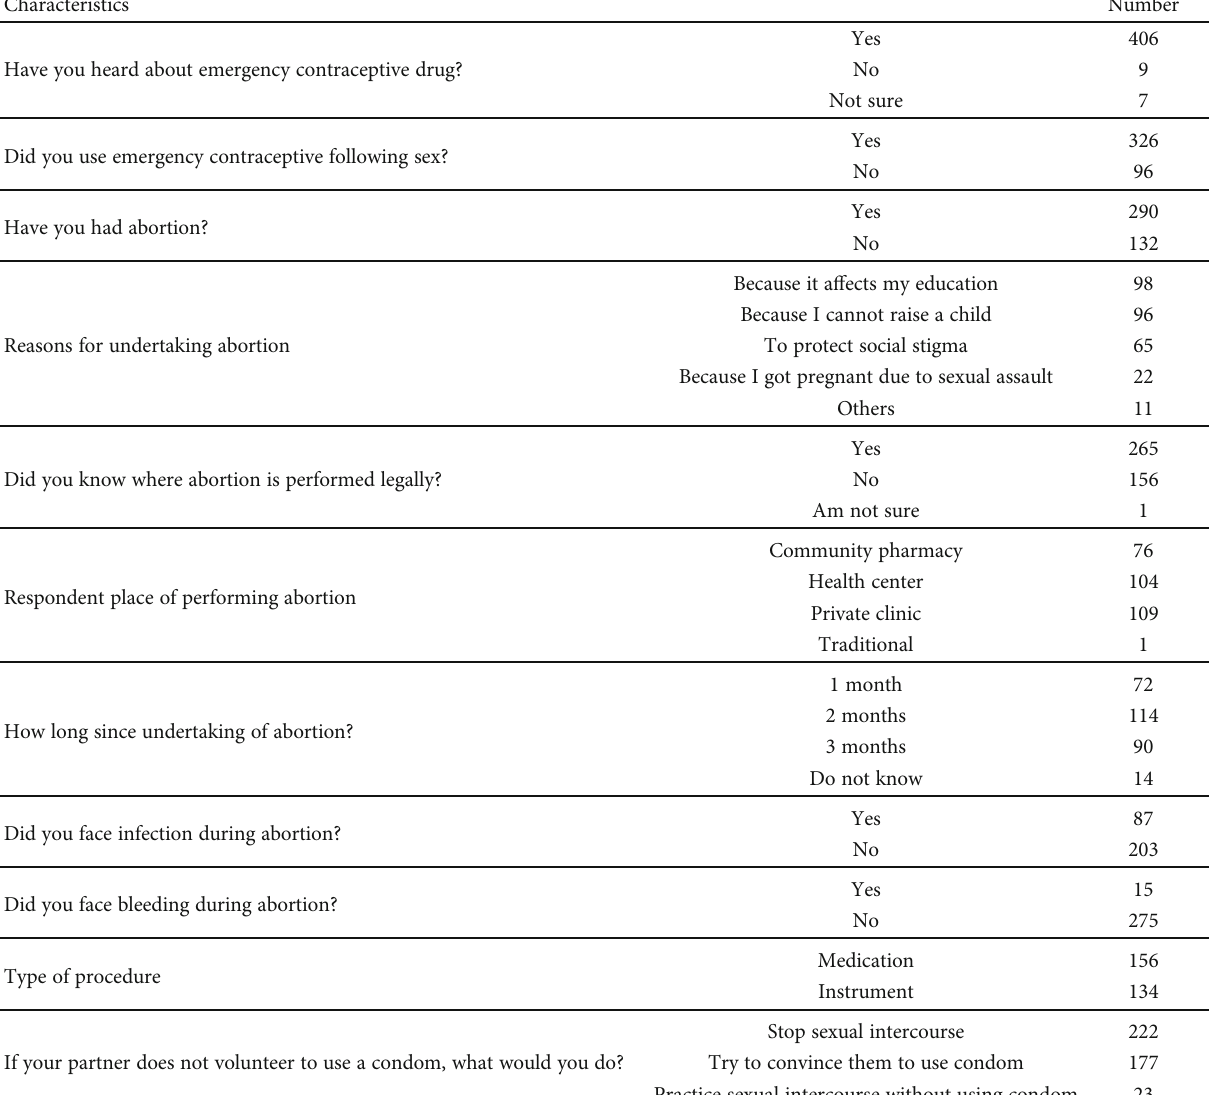
Table 3: Participants ’ knowledge of a place and complication of abortion at Hawassa University, SNNPR, Ethiopia, April 2019. Characteristics